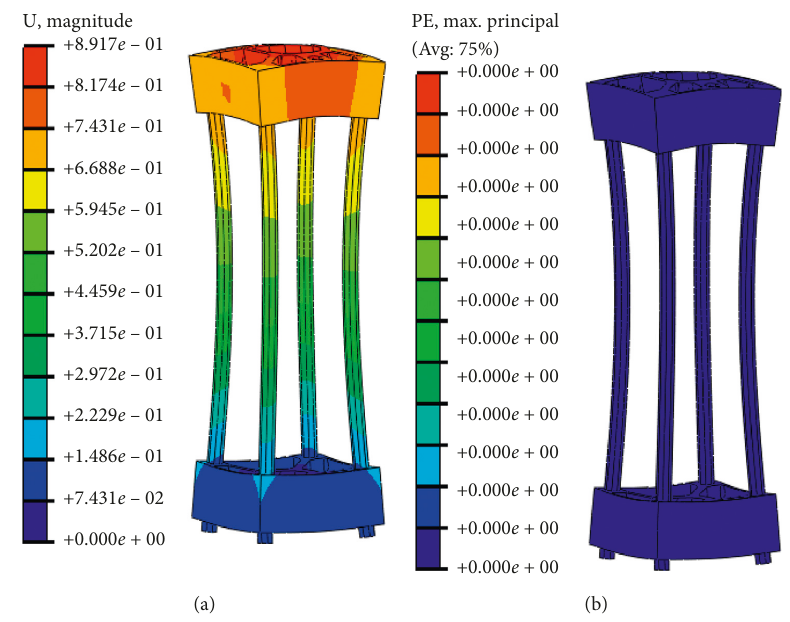
Figure 8: Impact displacement and plastic deformation nephograms of the testing frame. (a) Displacement. (b) Plastic deformation.